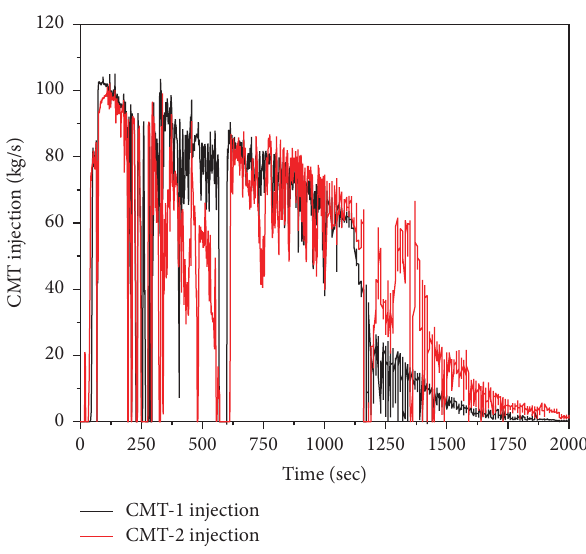
Figure 5: CMTs flow